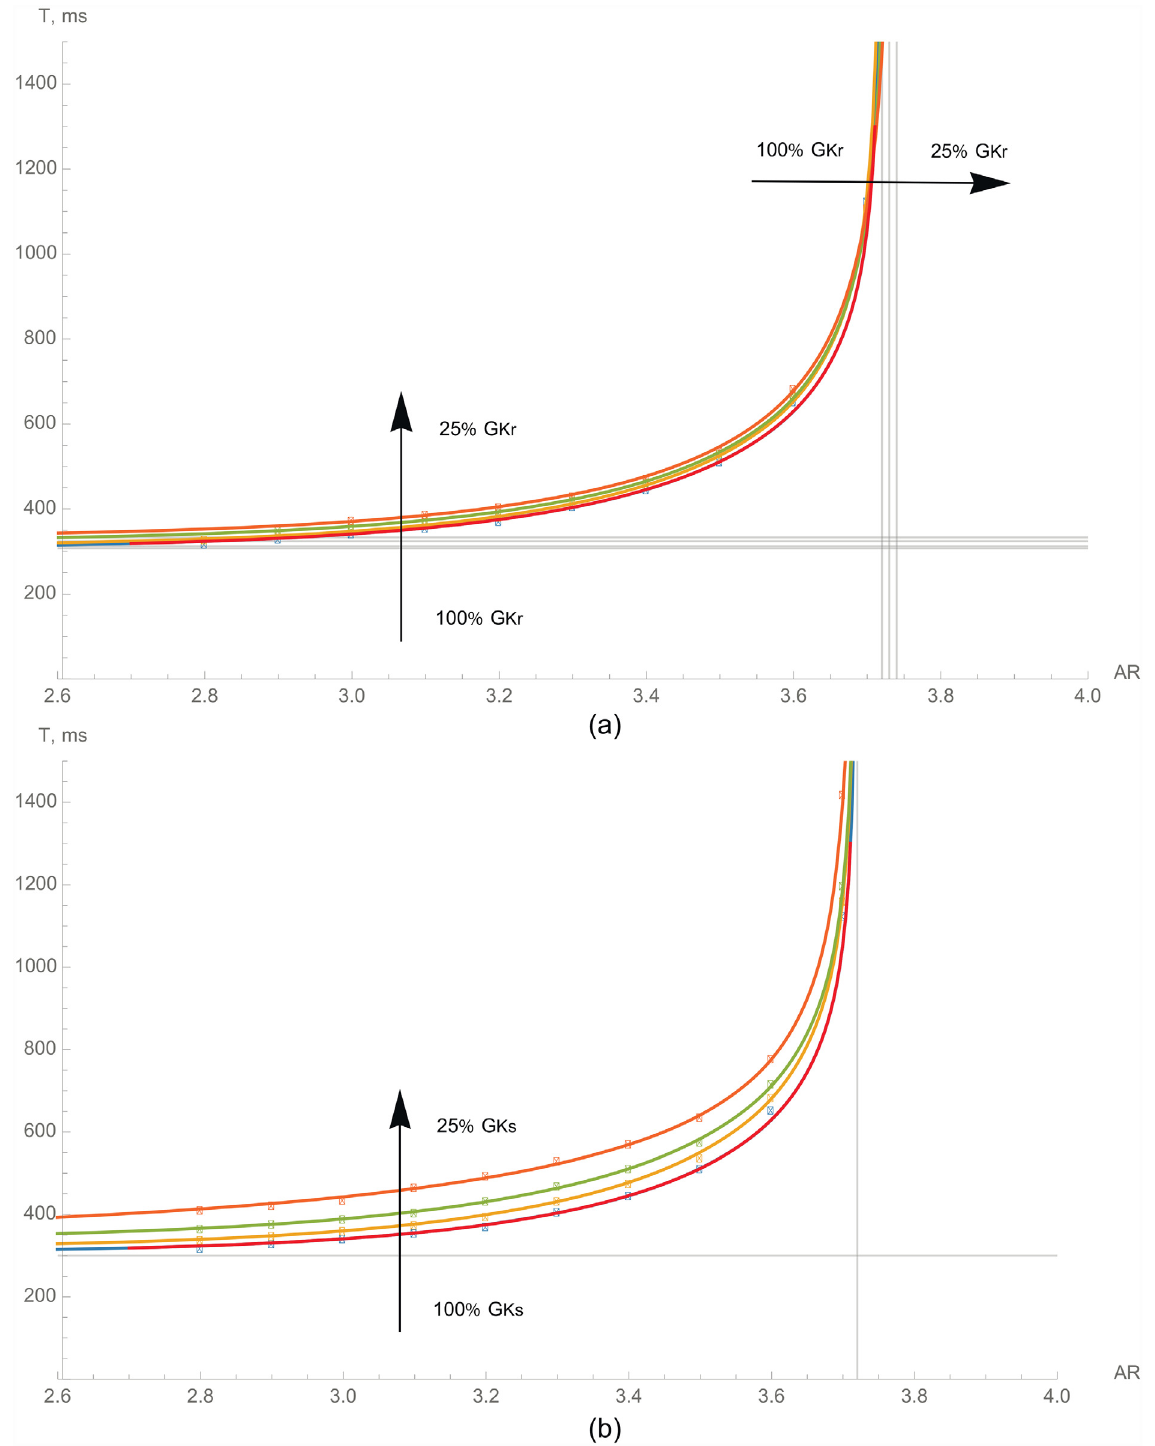
Fig 5. The dependencies of the critical period of stimulation on the AR for normal cardiomyocytes (red line) and with various potassium currents suppressed. Inhibition of (a) — I Kr and (b) — I Ks . The vertical asymptotes to these plots correspond to the critical AR for a single travelling pulse.